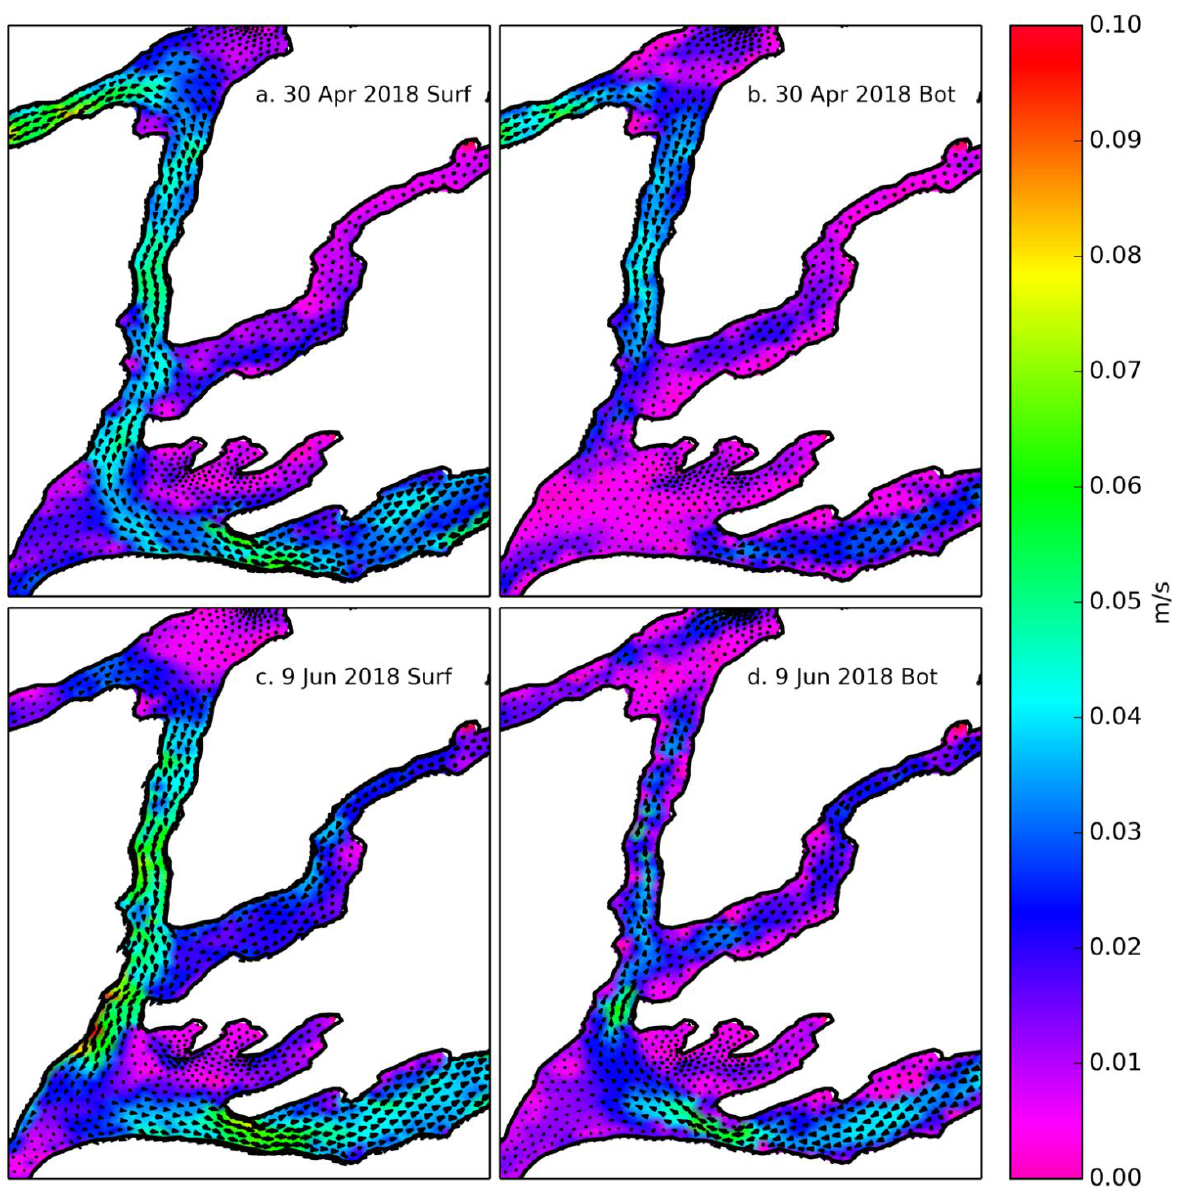
Figure 4. Middle bay flow fields at the ( a ) surface on 30 April 2018 and the ( b ) bottom on 30 April 2018 and at the ( c ) surface on 9 June 2018 and the ( d ) bottom on 9 June 2018. Directional arrow heads on top of magnitude in m/s.